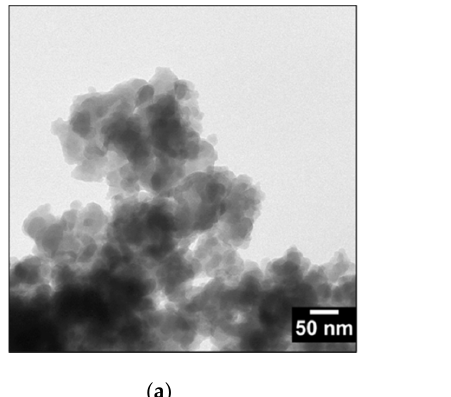
Figure 2. Representative HAADF-STEM micrograph and corresponding EDX spectrum of the PB_Com ( A , A’ , respectively) and PB_Syn ( B , B’ , respectively) sample.